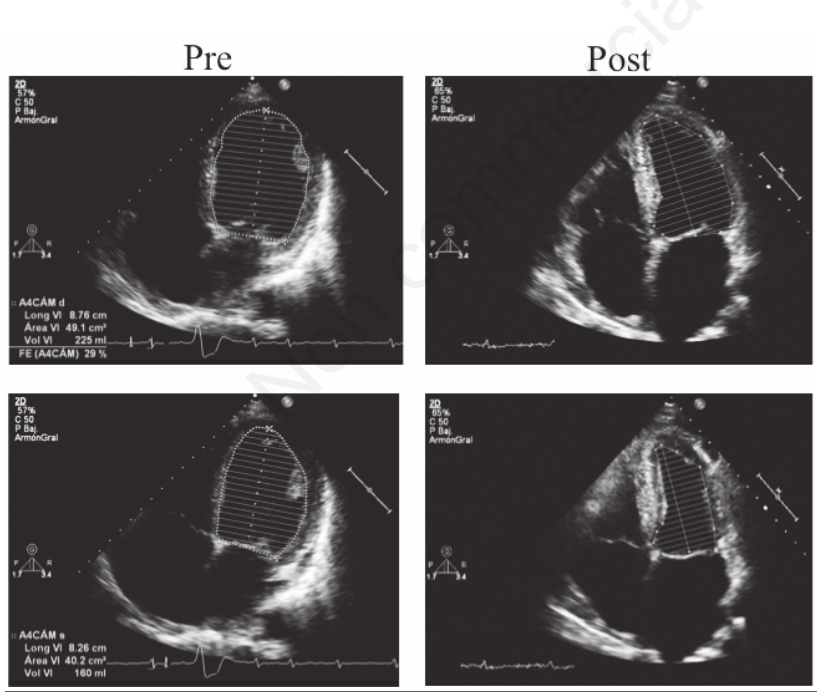
Figure 1. Echo still frame images (diastole top panels, systole bottom panels) from a 52- year old male admitted for acute heart failure and past medical history including hyper- tension, atrial fibrillation and consumption of 100 g of alcohol per day for more than 20 years and normal coronary arteries. An echocardiogram (left panels) showed a very dilat- ed left ventricle (LV), with LV ejection fraction <25% and right ventricular (RV) mild to moderate systolic dysfunction. An echocardiogram performed 6 years after first evalua- tion (right panels), after standard heart failure medication and complete alcohol intake withdrawal, shows normal LV and RV size and